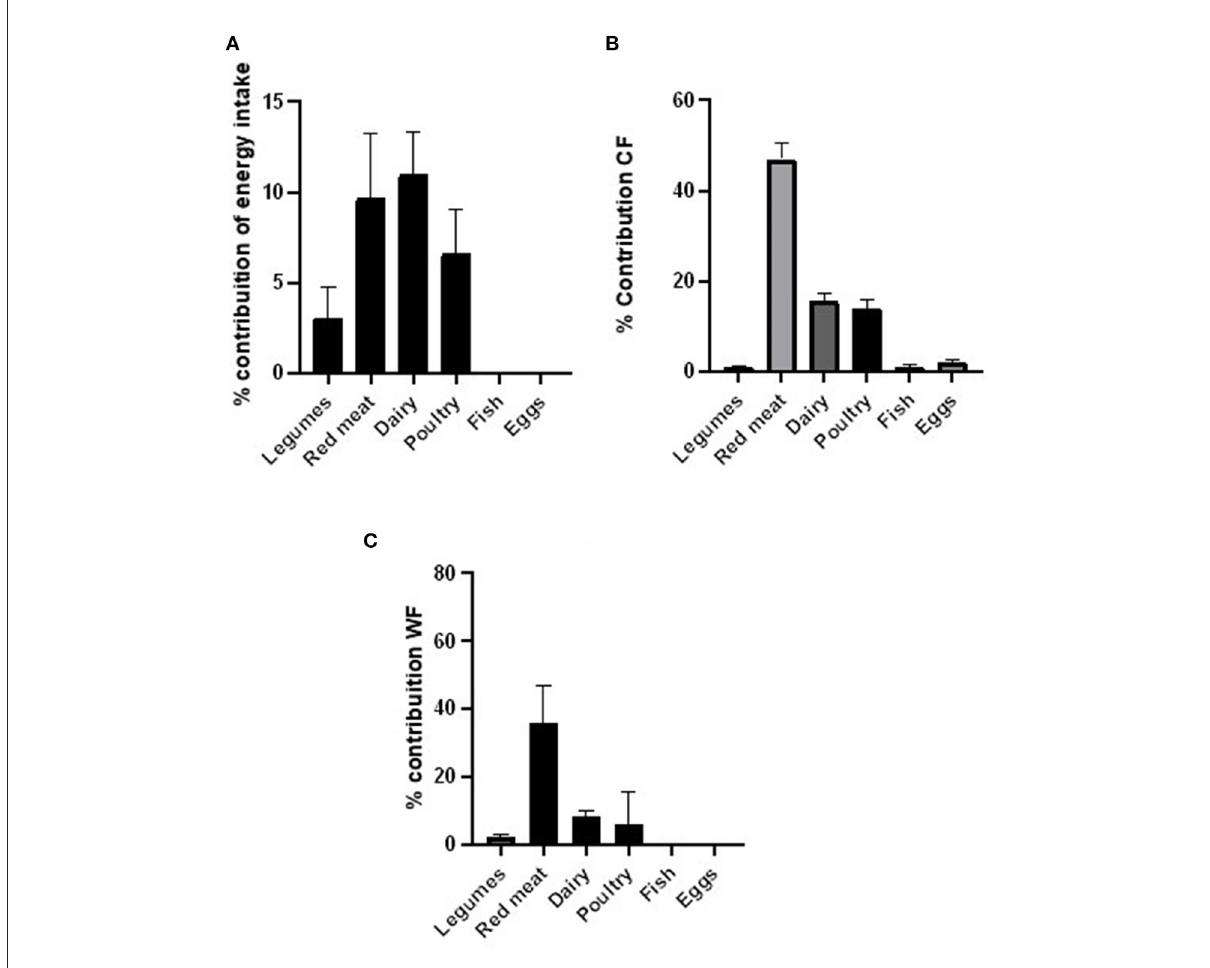
FIGURE2 Percentage contribution from Eat-Lancet reference diet food groups to energy intake (A) , carbon footprint (B) , and water footprint (C)